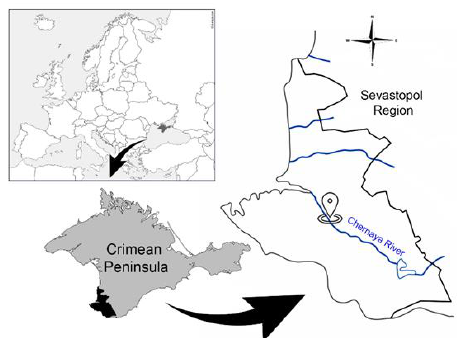
Figure 1. Location of the system for automated monitoring of the aquatic environment on Chernaya River (Sevastopol Region). River (Sevastopol